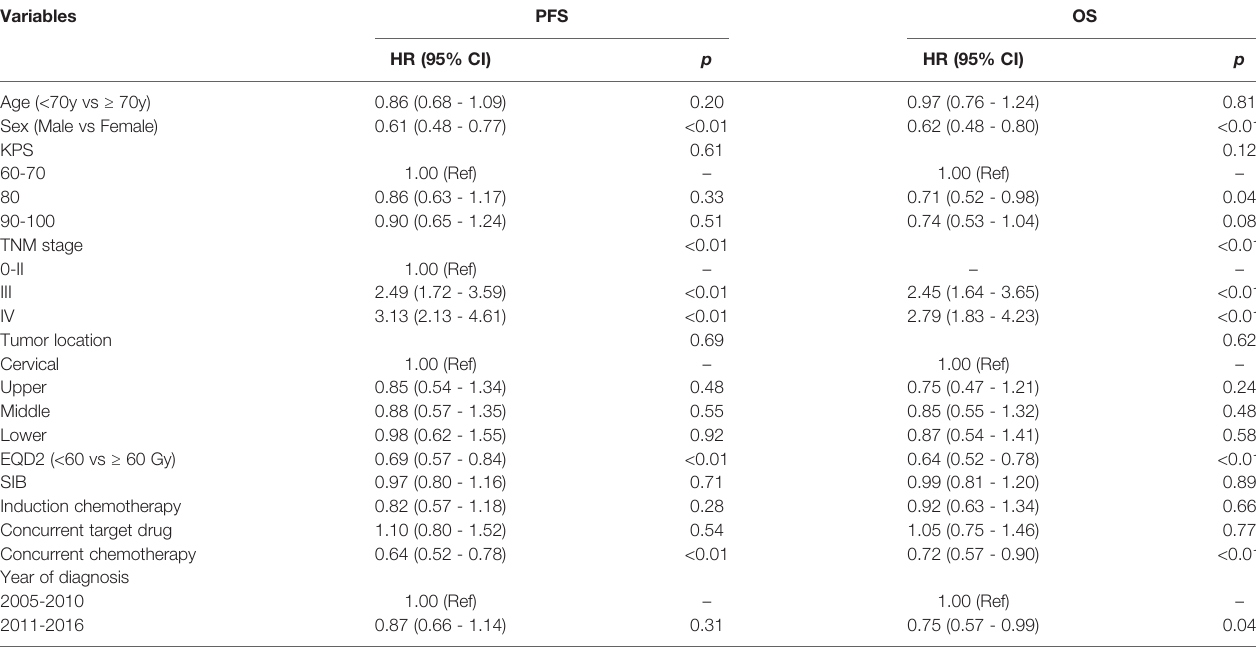
TABLE 3 | Multivariable analysis of predictive factors for progression-free and overall survival after propensity score matching.